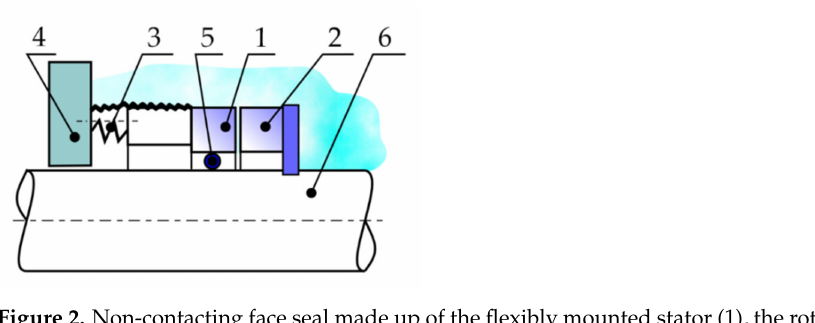
Figure 2. Non-contacting face seal made up of the flexibly mounted stator (1), the rotor (2), the spring